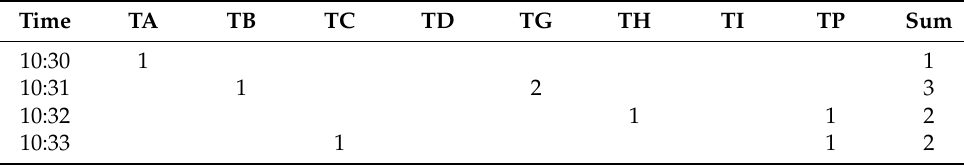
Table 4. Sample data collected at workplace C during the observation of 1 person.